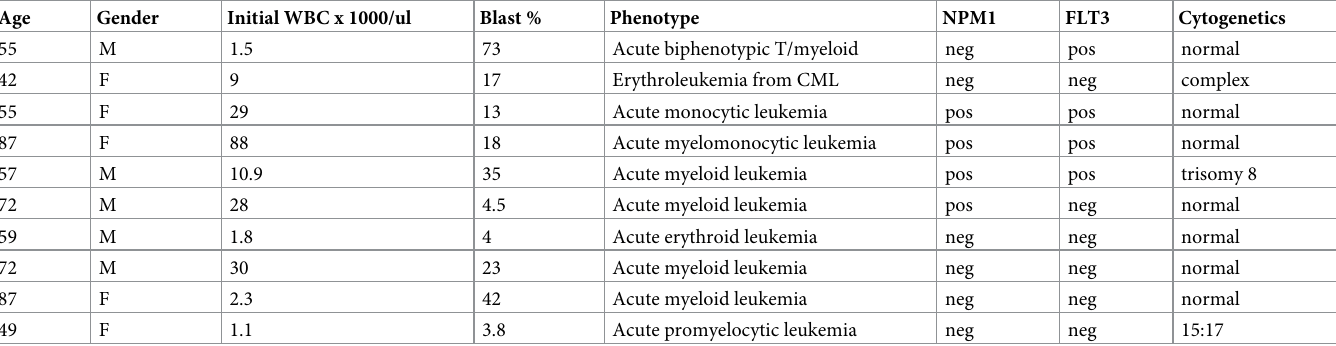
Table 1. Characteristics of patients in study.